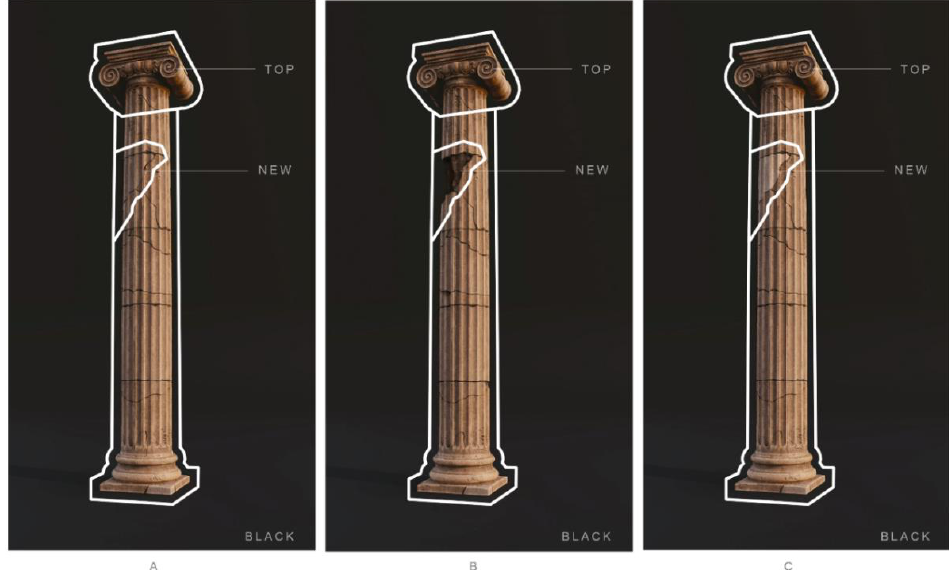
Figure 6. AOIs for stimuli ( A – C ).